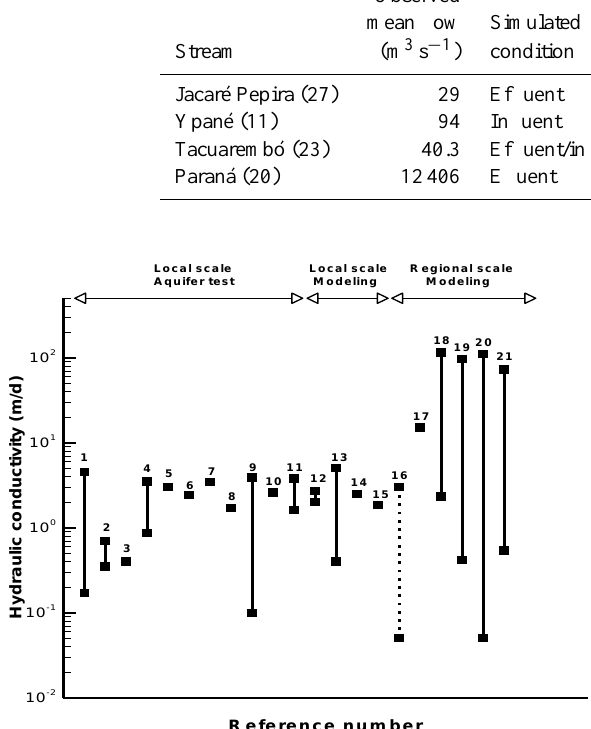
Fig. 12. Comparison between calibrated hydraulic conductivity and hydraulic conductivity values compiled from bibliographic sources. The group “Local scale aquifer test” includes aquifer tests data; the group “Local scale modeling” includes calibrated K from models ranging from 100km 2 to 5000km 2 in extent; the group “Regional scale modeling” includes calibrated K from models whose extent is larger than 400000 km 2 . Reference number 16 corresponds to the model of the Paraguayan sector of the GAS; references 17–21 cor- respond to the five zonations discussed in this work. K is reported either as a single value or a K range.